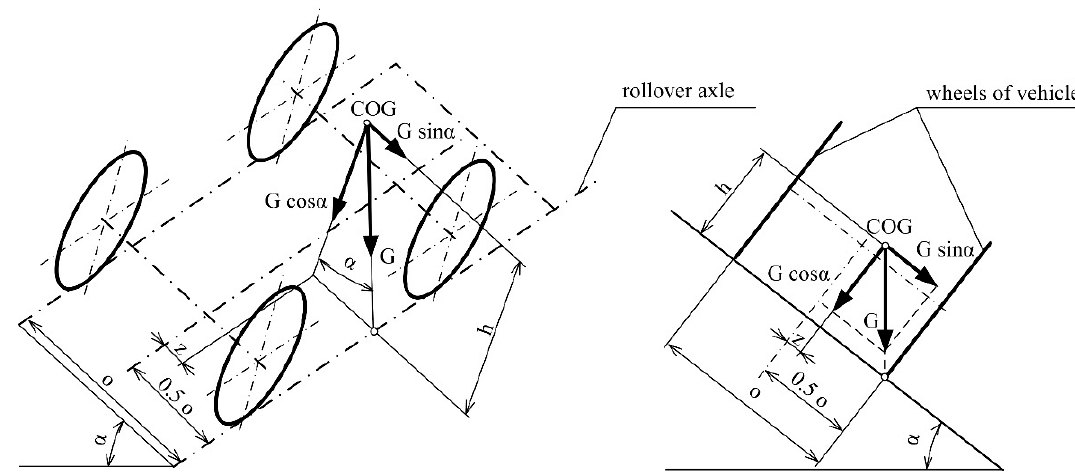
Figure 1. Forces acting on a vehicle inclined at the static overturning angle: o —overall width on tires; z —lateral position of center of gravity (COG); α —static overturning angle; h —vertical coordinate of COG; G —tractor weight.